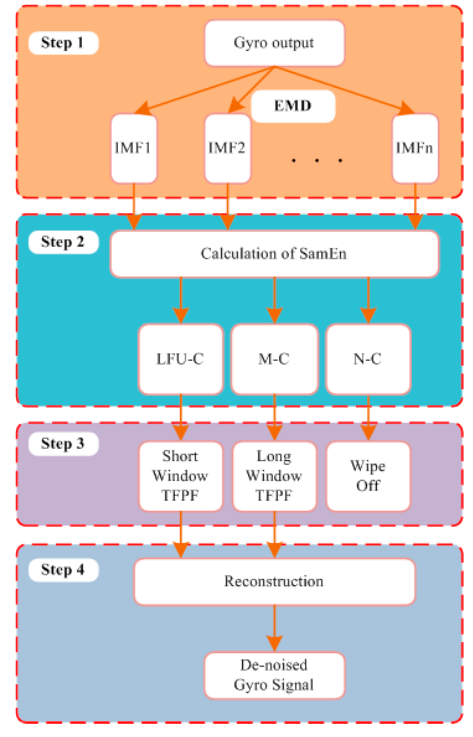
Figure 4. Steps of the proposed SEEMD-TFPF algorithm.